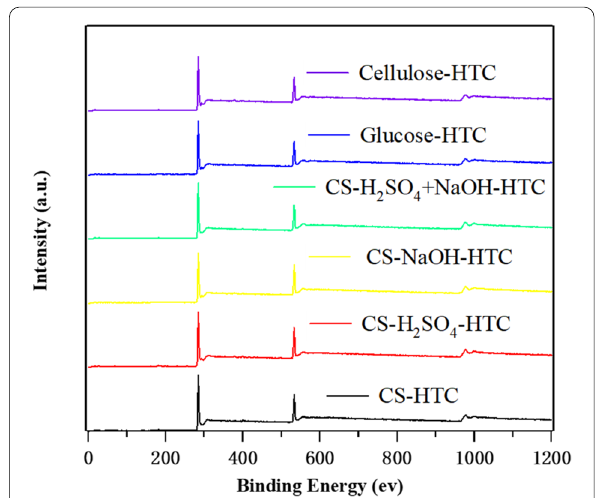
Fig. 5 XPS full-spectra of CS hydrochars, glucose and cellulose-derived hydrochars